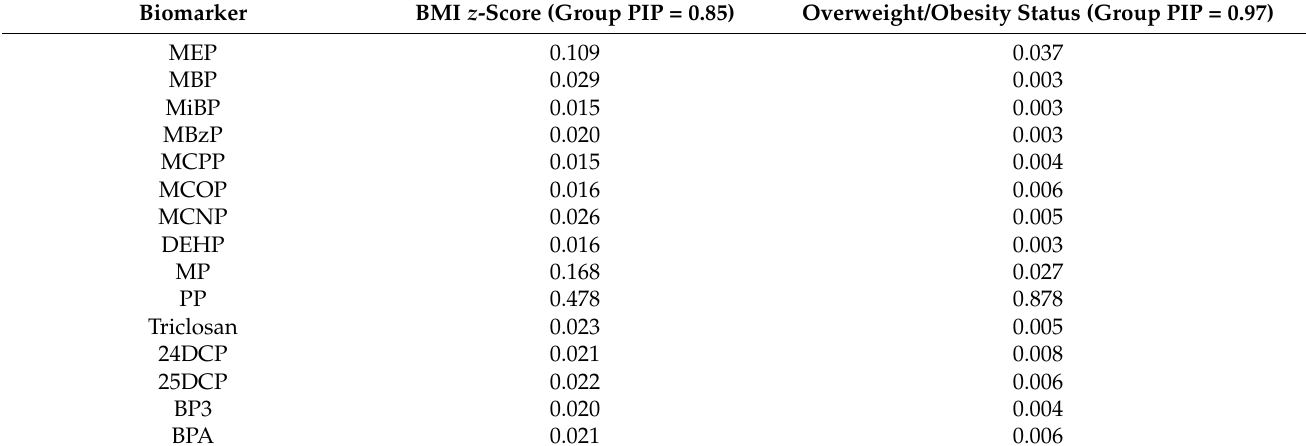
Table 4. Individual posterior inclusion probabilities from Bayesian kernel machine regressions ( N = 309).